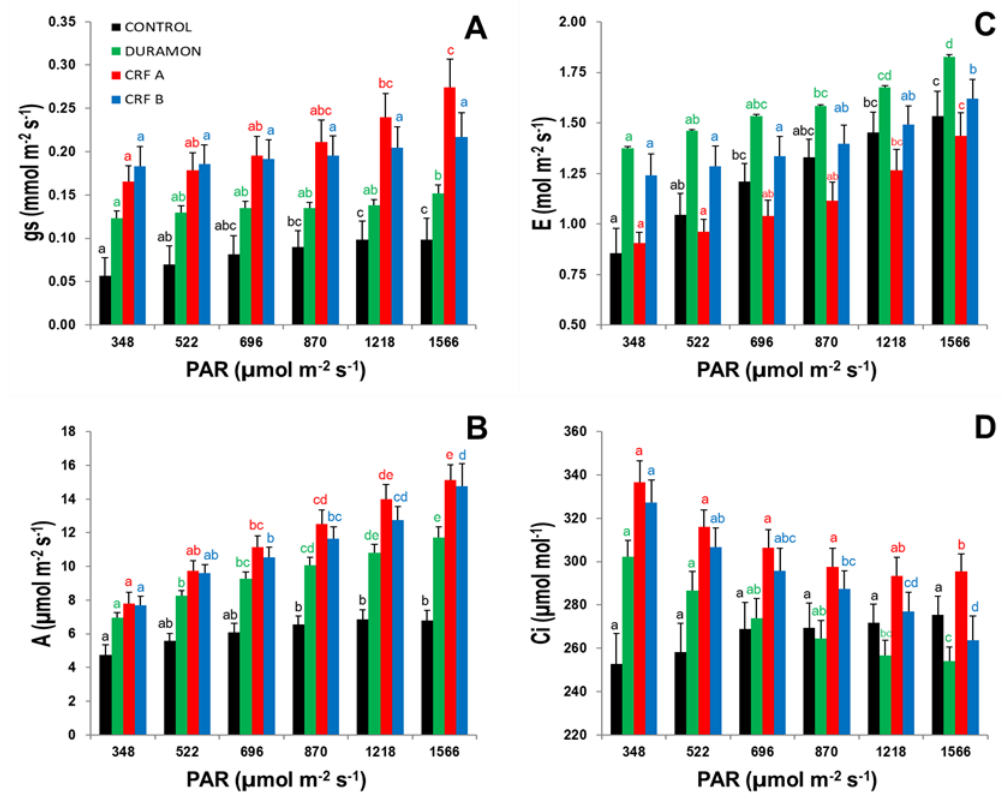
Figure 2. Gas exchange responses to different photosynthetically active radiation rates of Triticum aestivum treated with fertilizers CRF A , CRF B , DURAMON ® , and CONTROL in the phenological state of panicles swelling (booting stage). ( A ) Stomatal conductance, ( B ) net photosynthetic rate, ( C ) transpiration rate, and ( D ) substomatal CO 2 concentration. Values represent means ± SE ( n = 6). Different letters for each treatment (same color) indicate statistically significant differences (ANOVA, P < 0.05).